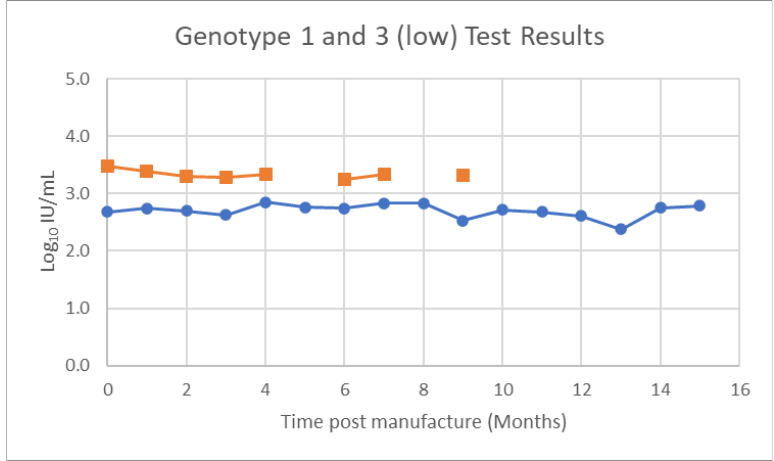
Figure 1. Results of monthly testing of whole blood dried tube samples for HCV Genotype 3 (blue) stored at − 20 °C for 15 months, and Genotype 1 (orange) stored for nine months. Invalid results were obtained for Genotype 1 for the 5th and 8th month.